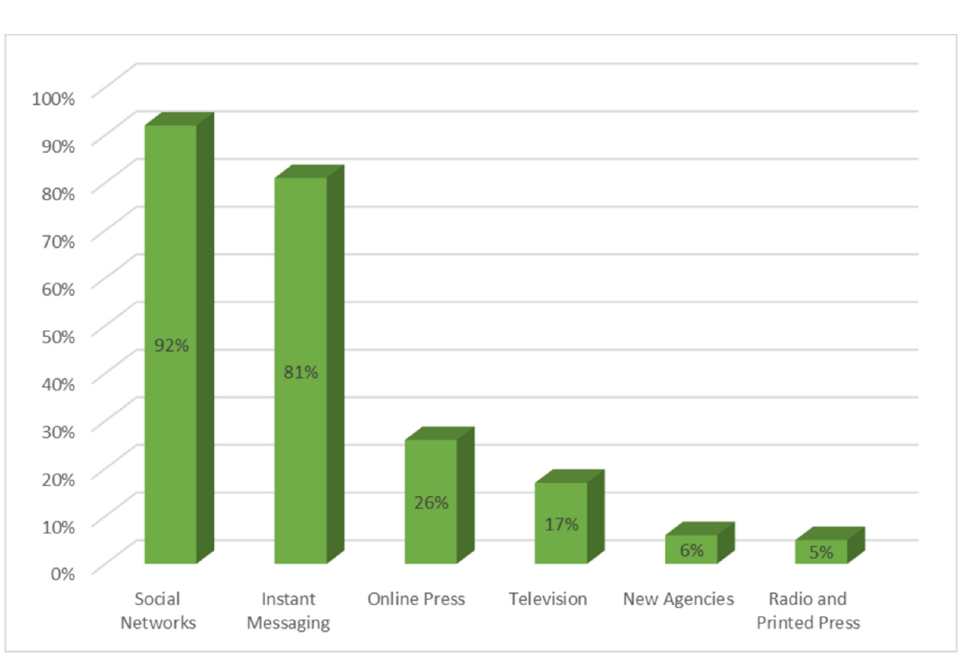
Figure 5. Media that citizens consider to have the highest amount of fake news.